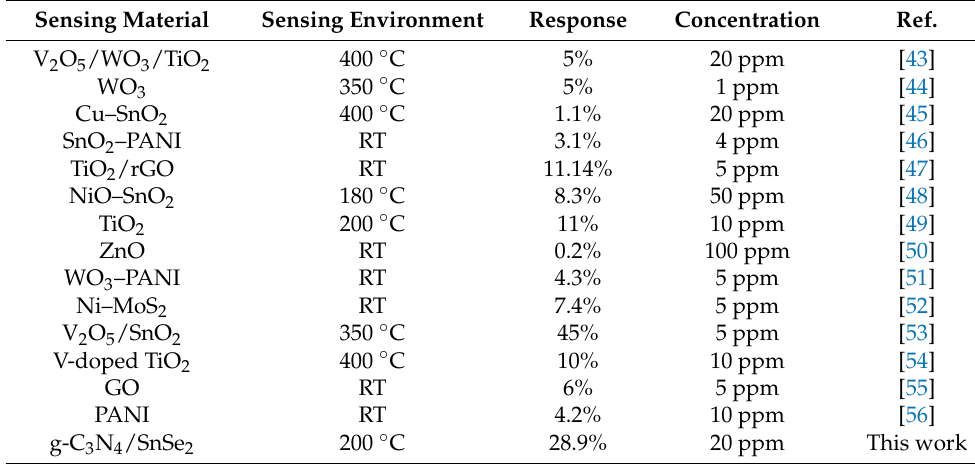
Table 1. Cont. Sensing Material Sensing Environment